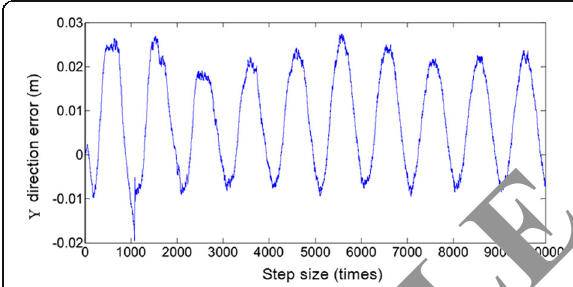
Fig. 9 Error analysis in the Y